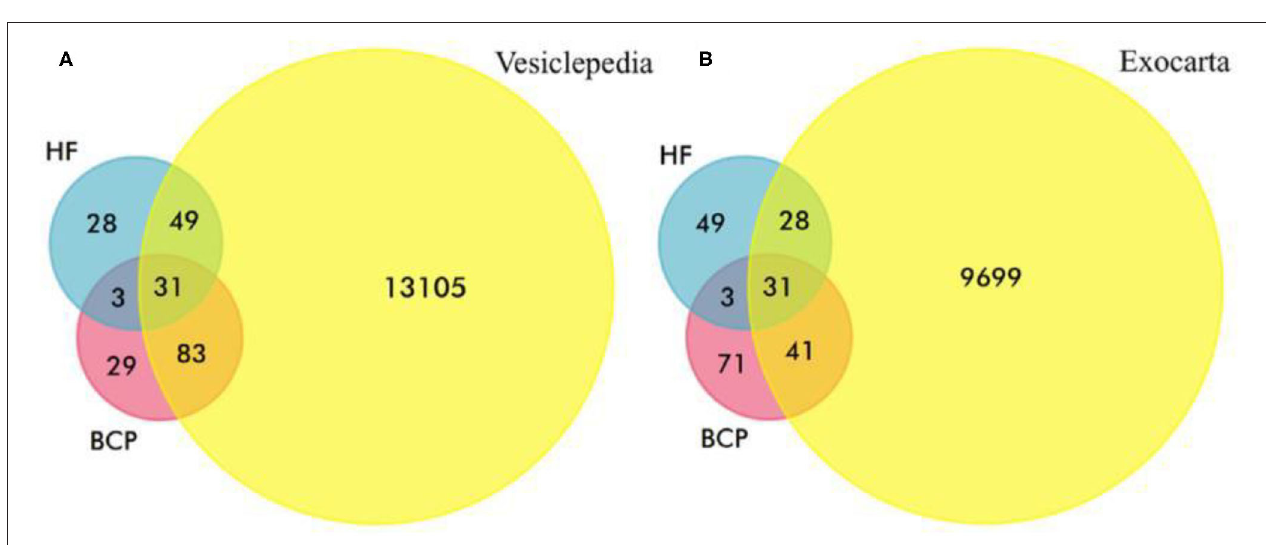
FIGURE 3 | Venn-Euler diagrams of exosomal proteins from HFs and BCPs (A) with Vesiclepedia and (B) Exocarta databases.